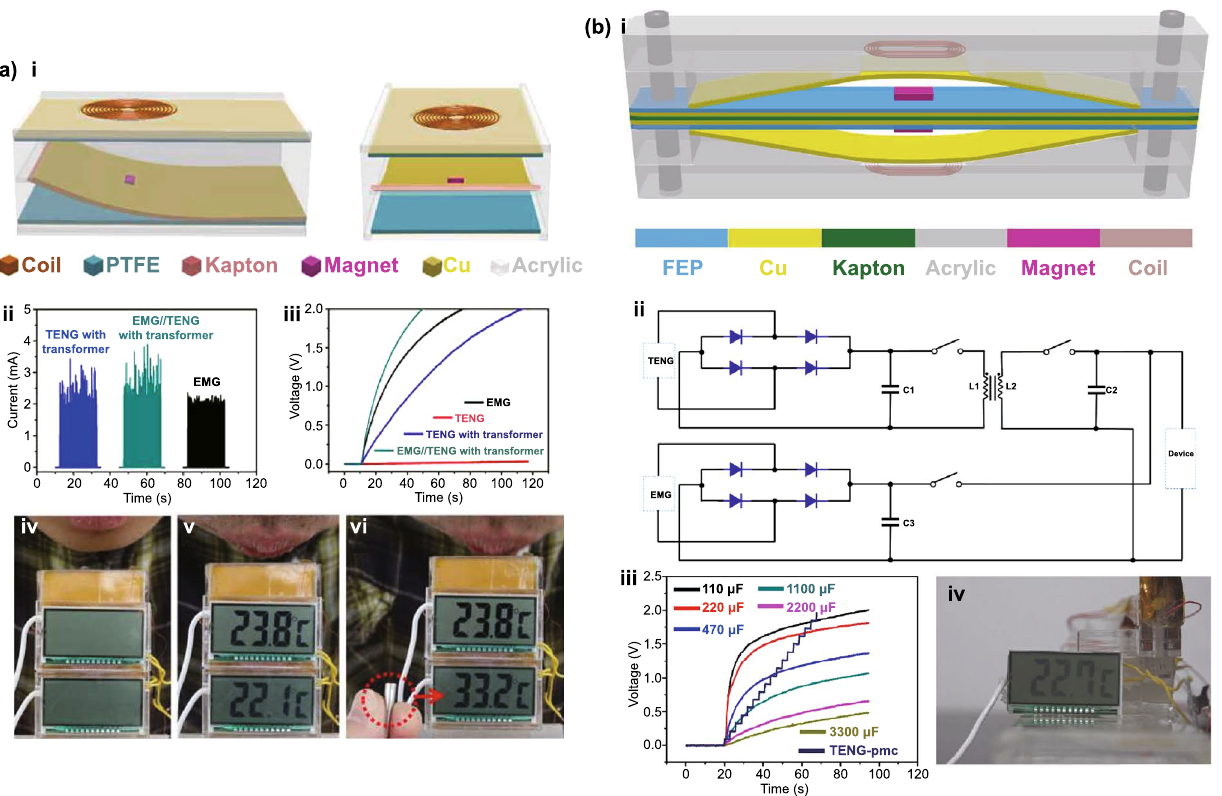
Fig. 25 a (i) Schematic diagram of the hybridized air-flow E-TENG nanogenerator designed by Wang et al. (ii) Rectified output current signals of the individual TENG unit, EMG unit and both units connected in parallel. (iii) Measured charging curves of a 3300 μF capacitor by using the different devices. (iv–vi) Scavenging of human mouth blown air-flow energy to sustain two temperature sensors. Reproduced with permis- sion from Ref. [48]. Copyright 2015, American Chemical Society. b (i) Schematic diagram of the hybridized nanogenerator fabricated by Wang et al. (ii) Designed power management impedance matching switching circuit with multiple capacitors for the hybridized nanogenerator. (iii) Measured charging curves of different capacitors by the EMG and 110 μF by the TENG with power management circuit (PMC). (iv) Photograph of a temperature sensor being powered by the generator. Reproduced with permission from Ref. [103]. Copyright 2016, Elsevier Ltd. All rights reserved. (Color figure